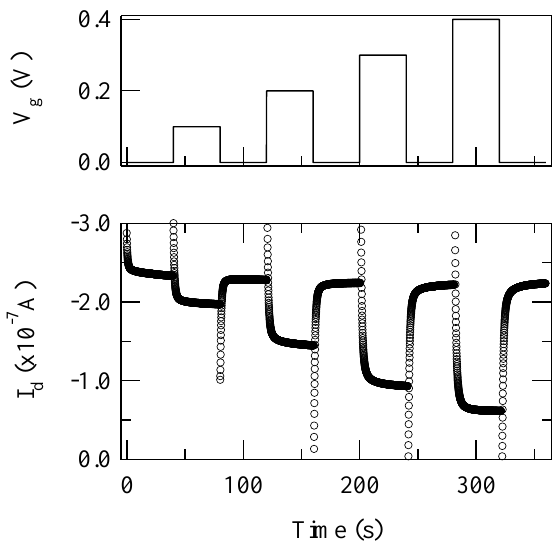
Figure 2. The application of a gate bias (a) causes a modulation of the drain current I PEDOT:PSS OECT